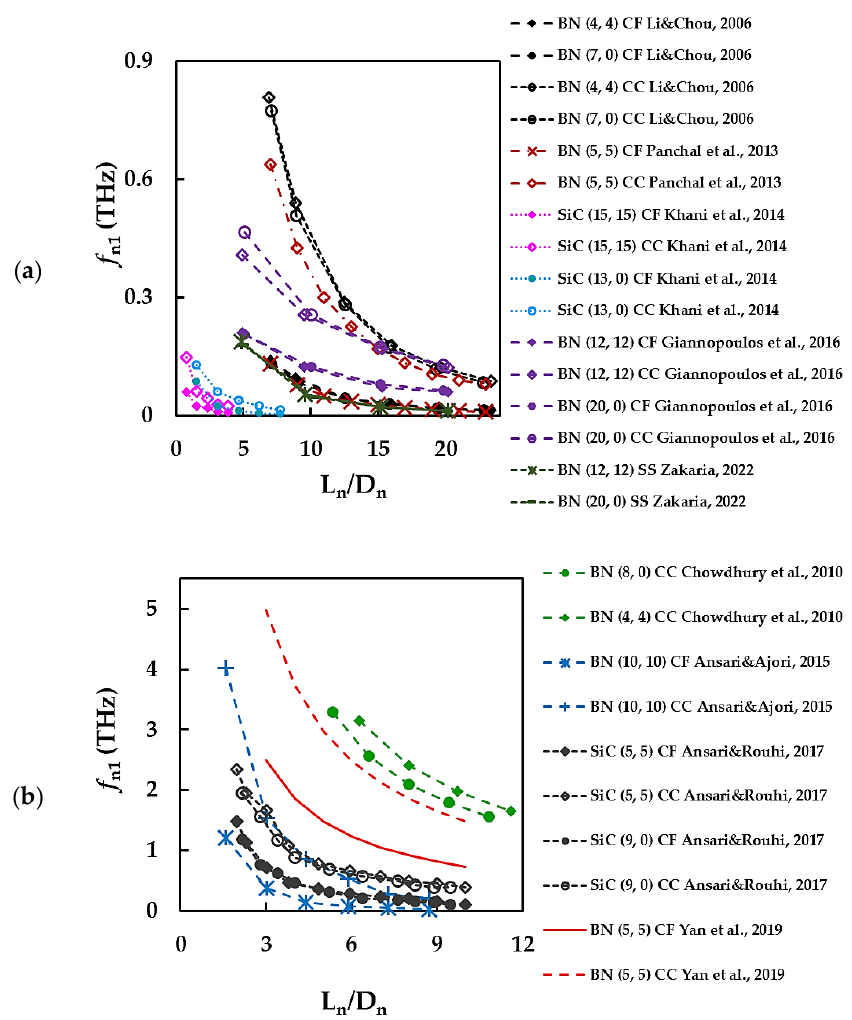
Figure 8. Thefirstfundamentalfrequency, f n1 ,asafunctionoftheNTaspectratio,L n /D n [34,57,67–69,71,98,100,101]; Figure 8. The first fundamental frequency, f n1 , as a function of the NT aspect ratio, L n / D n [34,57,67 – the f n1 valuesofcomparablemagnitudeareplottedonthedifferentgraphs( a , b 69,71,98,100,101]; the f n1 values of comparable magnitude are plotted on the different graphs ( a , b ).